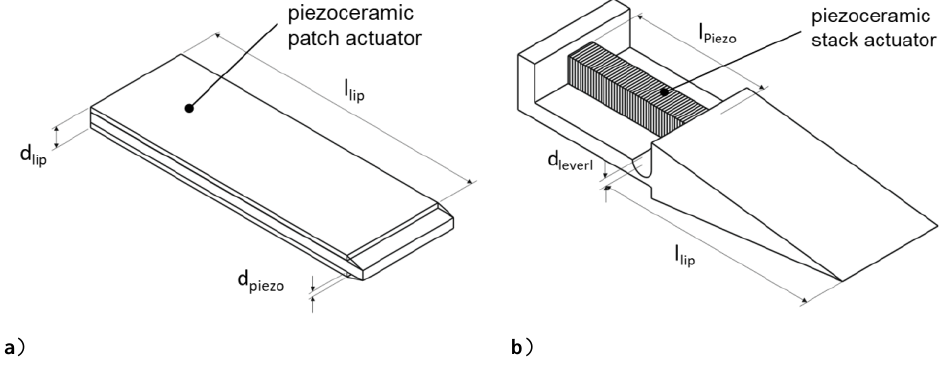
Figure 4. Actuator concepts for the active lip of the blown slot. a ) Piezoceramic bender in a trimorph configuration; b ) Compliant leverage with a piezoelectric stack actuator.